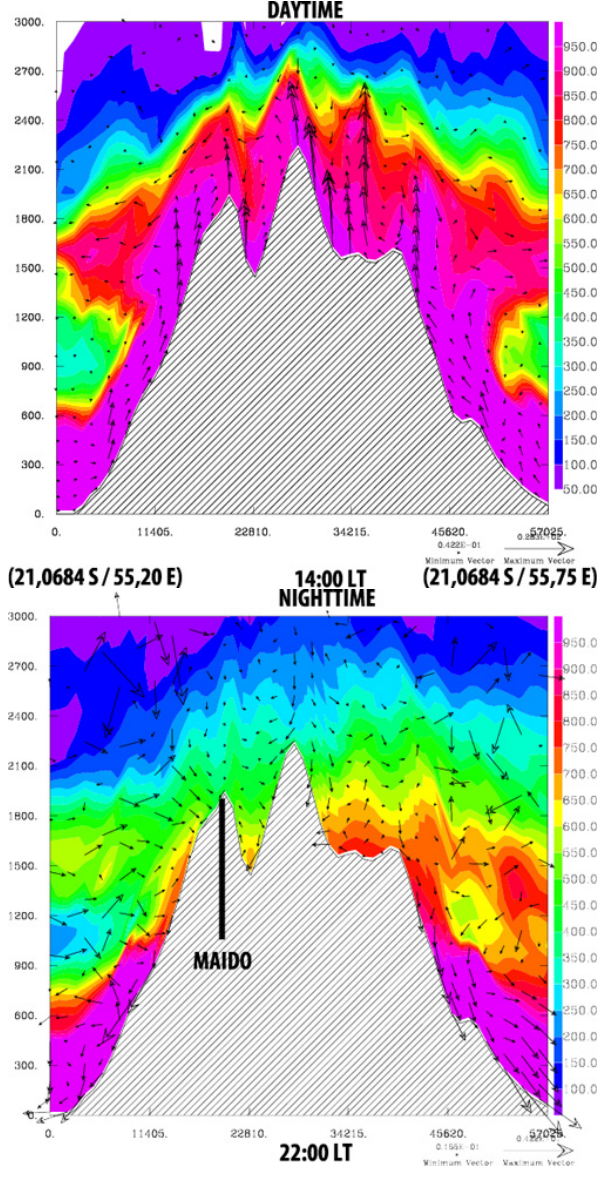
Fig. 4. Simulation ALIZ0: W-E vertical cross section of the island (indicated in Fig. 9, top) showing the ABL tracer concentration (per mil of the concentration in the “ABL”, see Sect. 3 and Fig. 5) at 14:00LT (top) and 00:00LT (bottom).